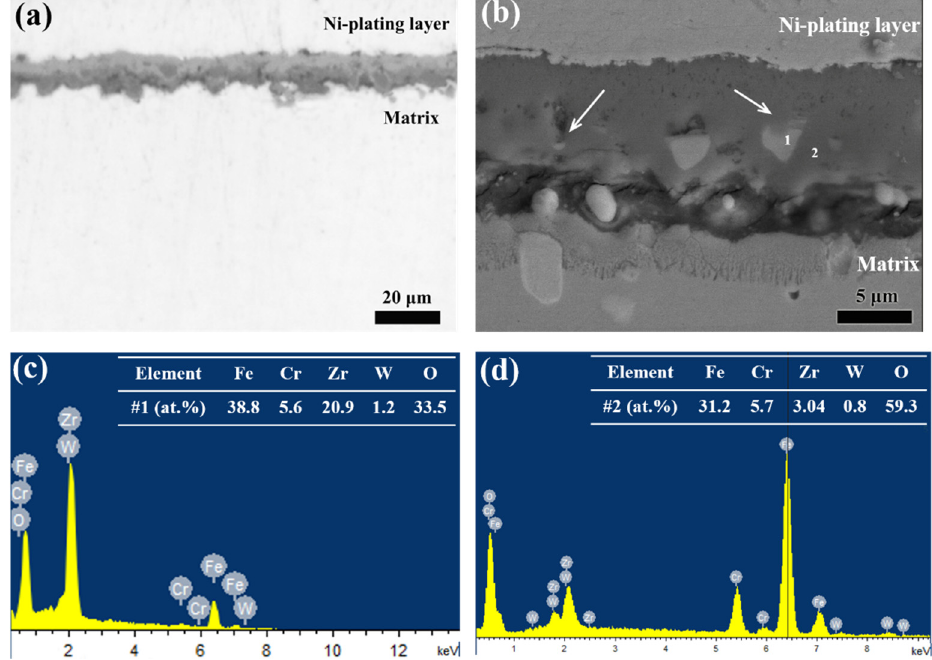
Figure 6. ( a ) OM and ( b ) BSE images of polished cross-sectional morphologies of Fe-Cr-Zr alloy after oxidation in air at 923 K for 20 h. ( c , d ) EDS spectrums for point 1 and point 2 marked in ( b ). OM image of the cross-sectional morphologies of scale after oxidation of 1000 h is shown in Figure 7a. A roughened surface is observed, which is corresponding to